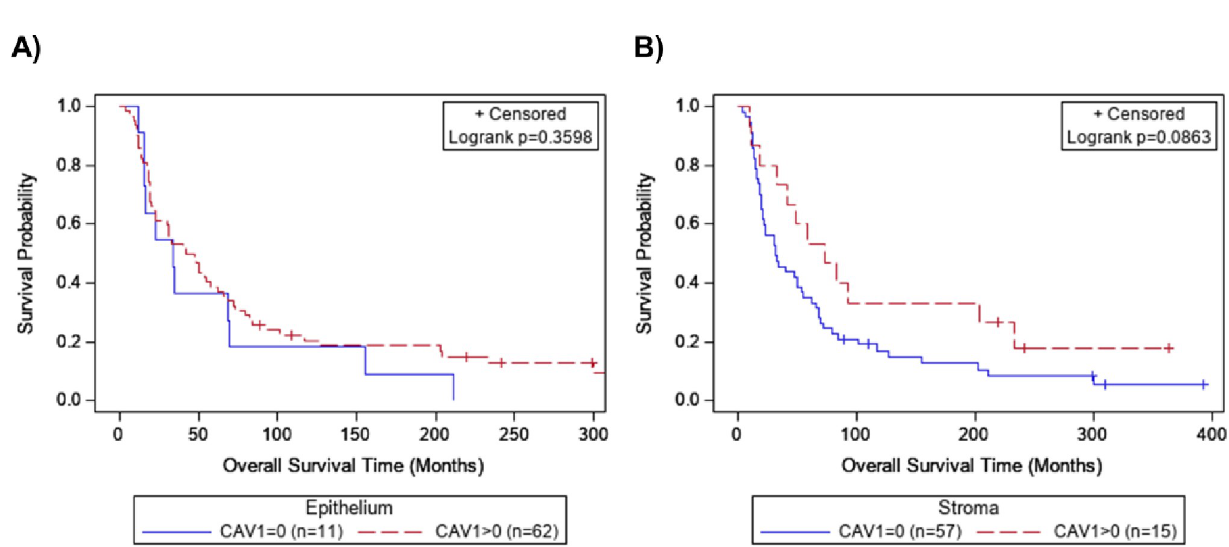
Fig 2. Overall survival of serous ovarian cancer by expression of Cav-1 in Cohort 1. Kaplan-Meier survival curves for Cohort 1 by presence of Cav-1 immunohistochemical expression in the (A) tumor epithelium and (B) stroma using an immunohistochemistry H-score of zero as a cutoff.